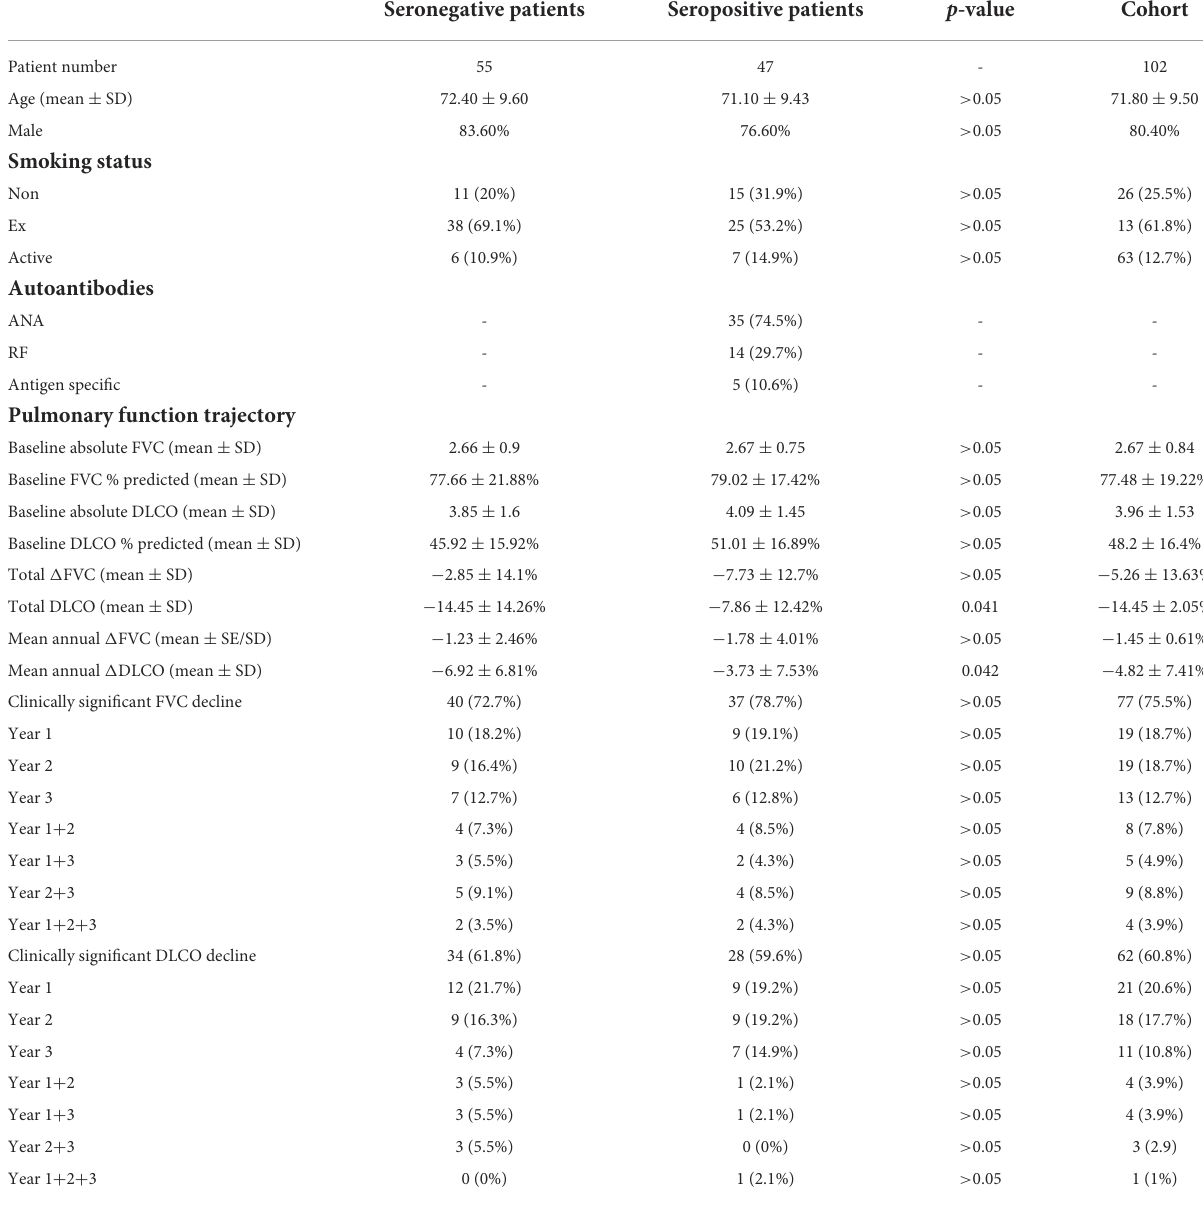
TABLE 1 Cohort demographic data and evolution of pulmonary function test parameters for seronegative patients and seropositive patients. Seronegative patients Seropositive patients p -value